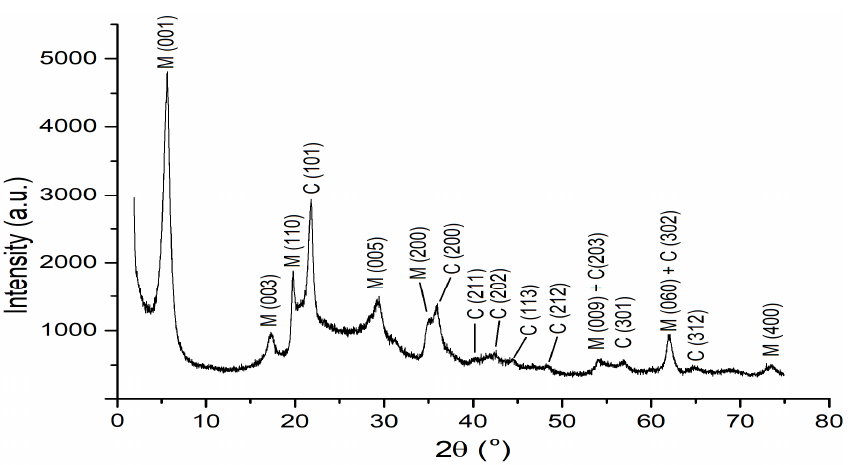
Figure 5. The XRD pattern of the white bentonite sample separate from Ora ș u Nou (M = Montmo- rillonite, C = Cristobalite). lonite, C = Cristobalite).